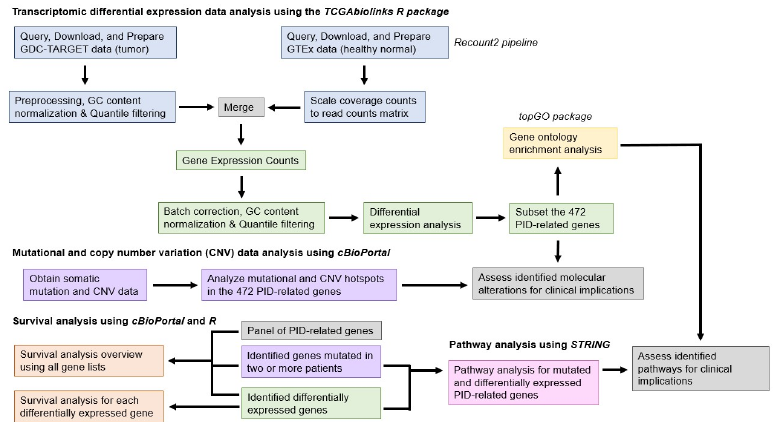
Figure 1. Workflow illustrating steps used in this study to identify the altered molecular character ‐ istics of PID ‐ related genes in pediatric cancer tumor tissues. tics of PID-related genes in pediatric cancer tumor